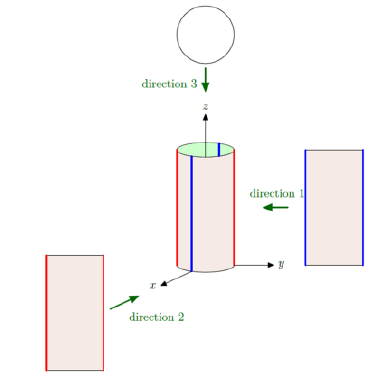
Figure 11. Cylinder representation given three view directions. For that purpose, a rotation of the cylinder frame around the cylinder axis is performed until the cutting plane is perpendicular to the view direction. This must be calculated before the plane is developed (Figure 12b), since the contour points of the plane become the contour of the cylinder.